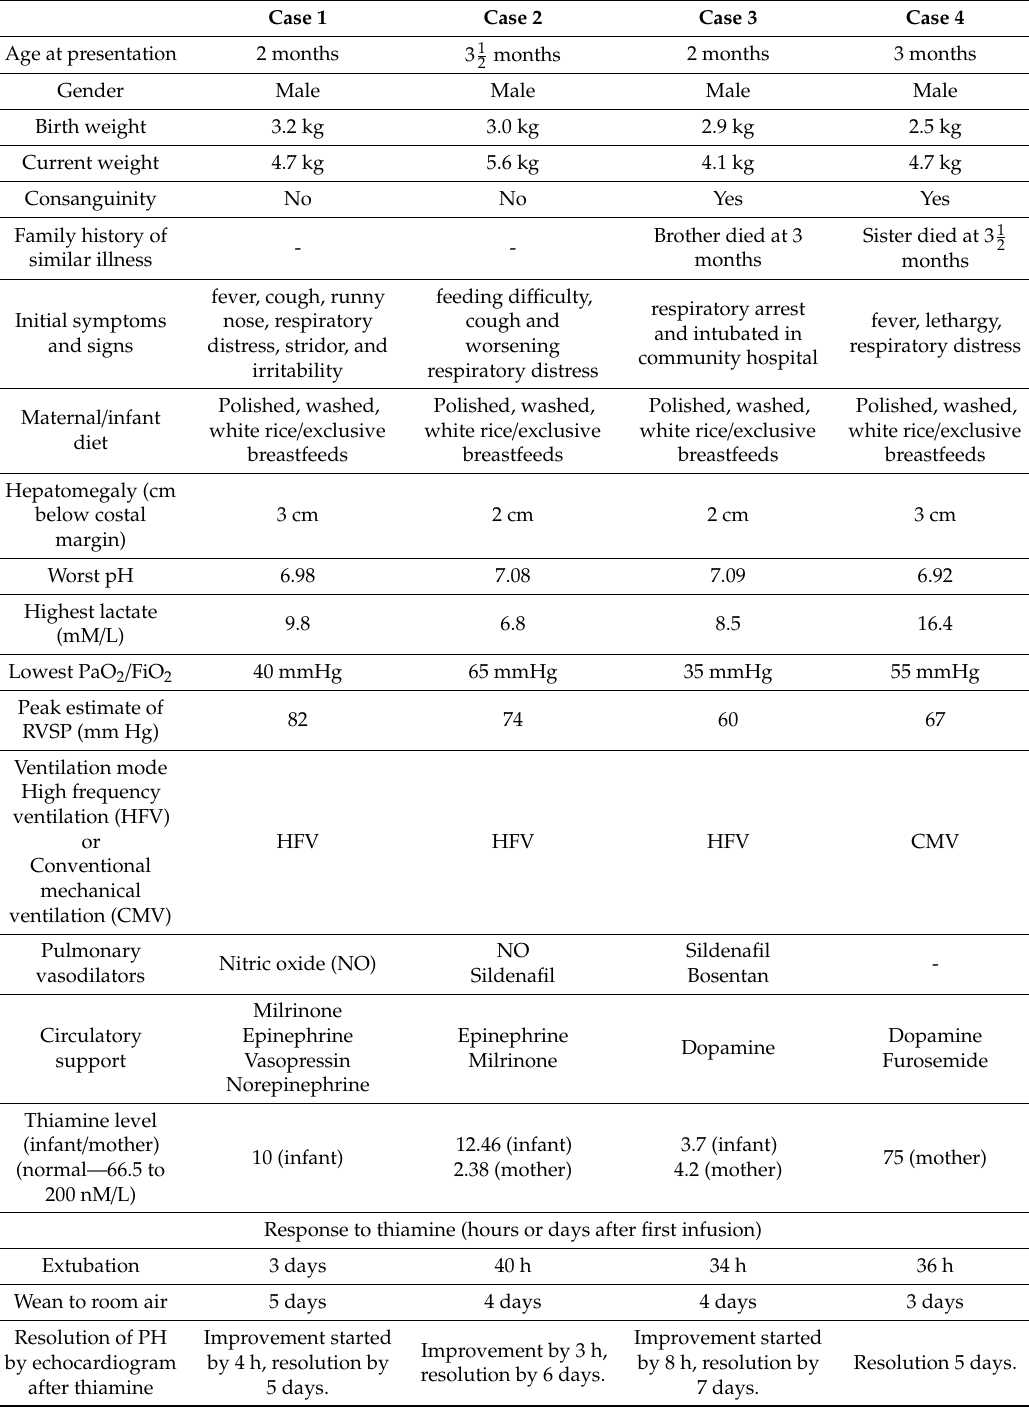
Table 1. Clinical presentation of four cases of thiamine-responsive acute pulmonary hypertension of early infancy